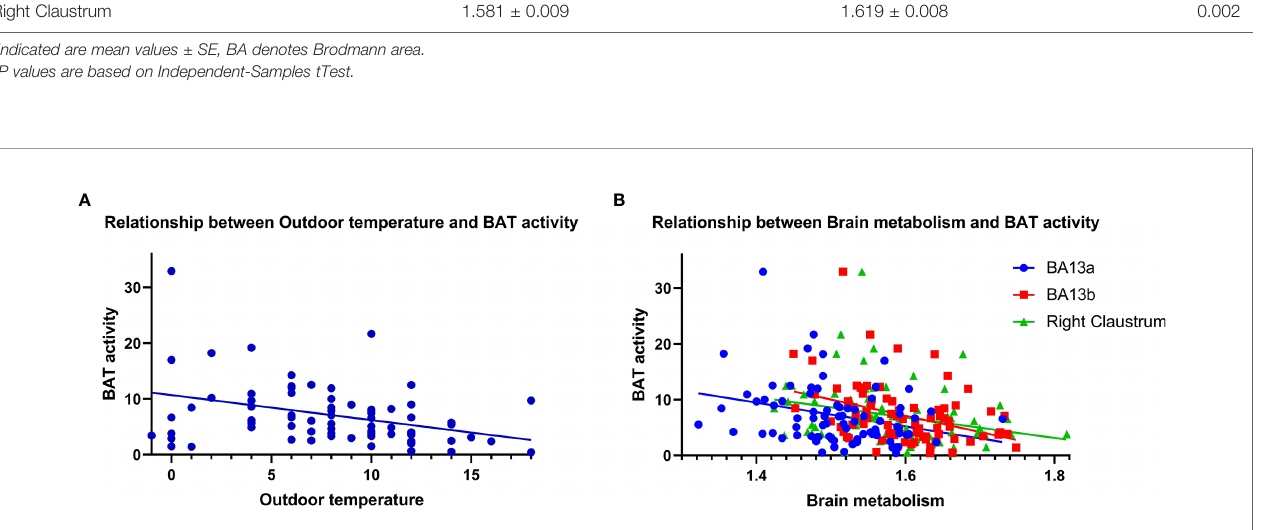
TABLE 3 | The semi-quantitative values of brain regions with signi fi cant metabolic differences between BAT positive group and BAT negative group*. Brain region BAT -positive (n = 80) Right Sub-lobar, Insula (BA13 a )